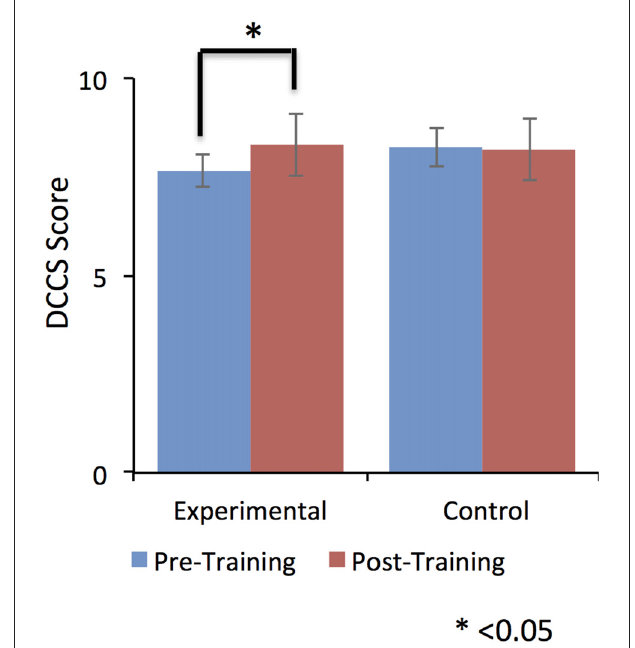
FIGURE 5 | Dimensional change card sort (DCCS) scores were significantly increased from pre-training to post-training in the experimental group (EG). No effect was observed for the control group (CG). This result suggests a positive effect of self-regulation of bilateral anterior insula on older adult’s cognitive flexibility. Error bars represent the standard deviation in DCCS